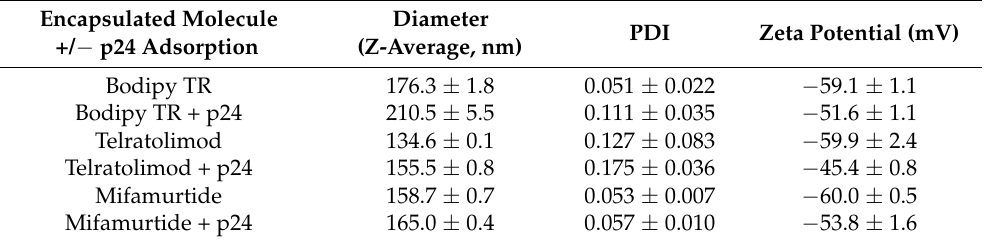
Table 1. Physicochemical characteristics of PLA-NPs (+/ − p24 protein) after encapsulation of telratolimod, mifamurtide, and bodipy TR dye. PDI: polydispersity